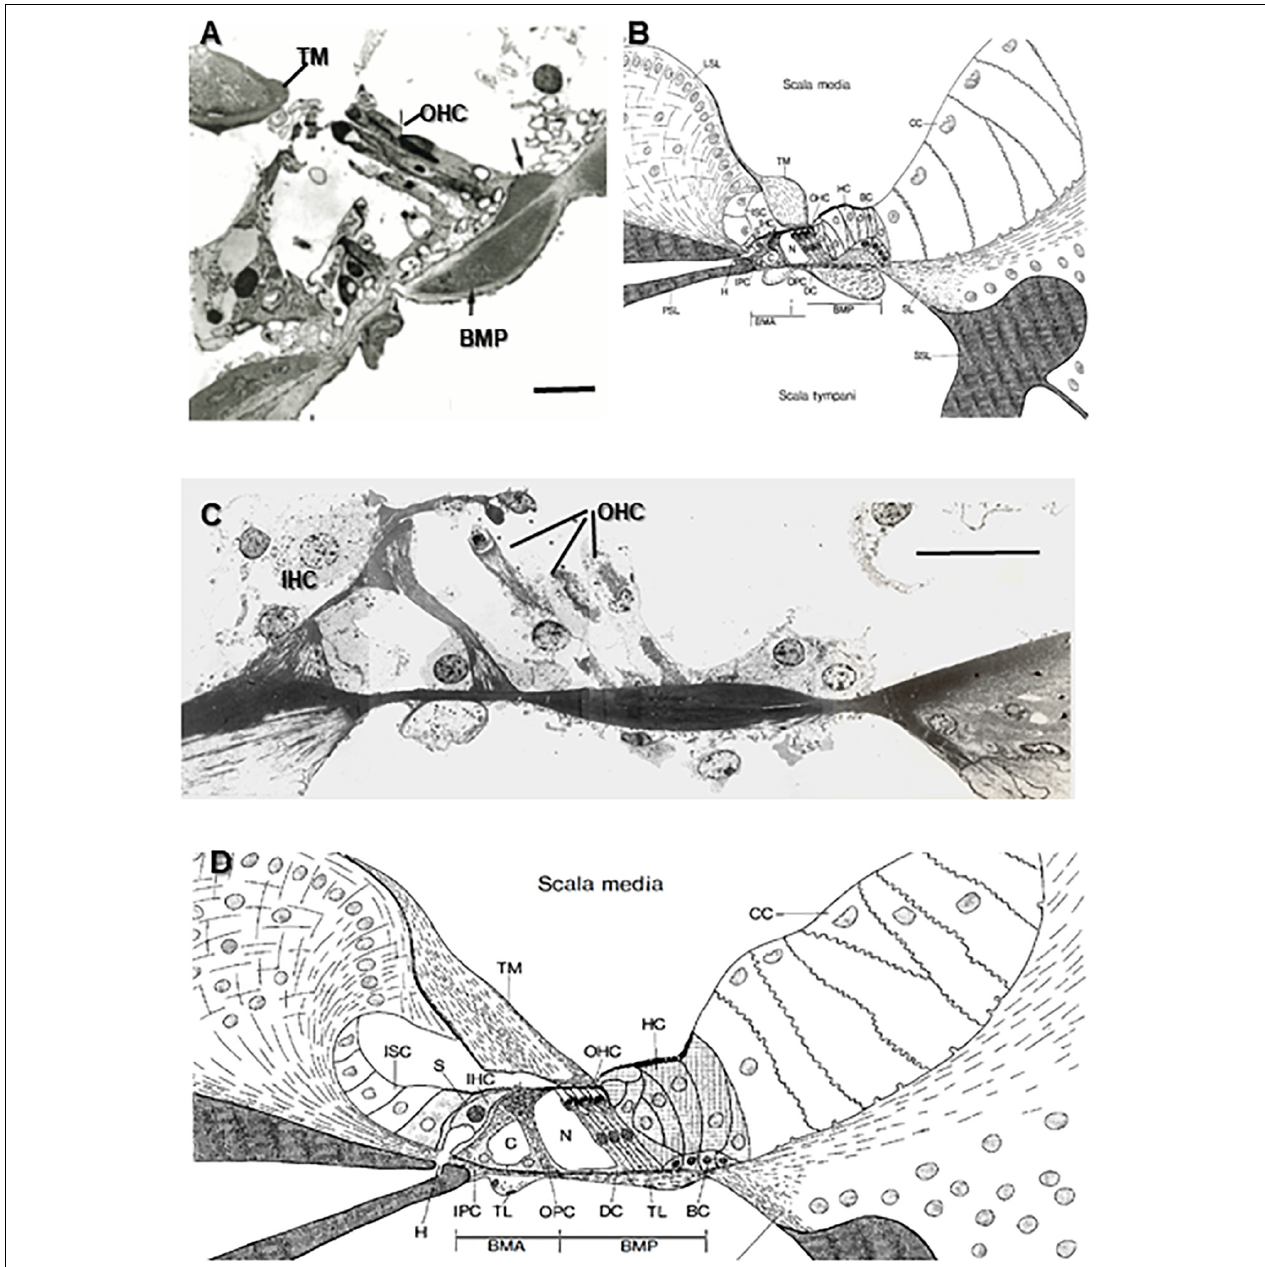
FIGURE 5 | Transmission electron microscopy (TEM) images of odontocete basilar membranes and organ of Corti compared with schematics of the cochlear sections from the horseshoe bat ( Rhinolophus ferrumequinum ). The specialized basal regions of the porpoise and bat have similar thickened regions of collagen fibers (arrows) attached to the basilar membrane that run longitudinally (scala media side) and transverse/radially (scala tympani side) that are hypothesized to act as stiffening agents. In both species, the outer hair cells (OHC) sit atop the bundle of longitudinal fibers. Specialized bundles are absent in the upper basal and second turn of the bottlenose dolphin and bat. Note: Because the OHC are actually staggered, all three may not be fully shown in the TEM images. This is not indicative of hair cell loss. BMA, Arcuate zone of the basilar membrane; BMP, Pectinate zone of the basilar membrane; C, Tunnel of Corti; CC, Claudius’ cells; DC, Deiters’ cells; H, Habenula; HC, Hensen’s cells; IHC, Inner hair cells; IPC, Inner pillar cells; ISC, Inner sulcus cells; LSL, Limbus of the spiral lamina; N, Nuel’s space; OHC, Outer hair cells; OPC, Outer pillar cells; PSL, Primary spiral lamina; S, IHC supporting cells; SL, Spiral ligament; SSL, Secondary spiral lamina; TL, Tympanic layer; TM, Tectorial membrane. Scale bars = 0.02 mm [TEM images copyright© 2021 DK, all rights reserved. Diagrams from Bruns (1980) reprinted by permission from Nature/Springer from Anatomy and Embryology, vol. 161]. (A) TEM image from the specially adapted lower basal half turn of a harbor porpoise ( P. phocoena , 1200X magnification). (B) Schematic from Bruns (1980) of lower basal turn location in the horseshoe bat (right, R. ferrumequinum ). (C) TEM image from the unspecialized region of the upper basal turn in a bottlenose dolphin ( T. truncatus 2000X magnification). (D) Schematic of the basilar membrane and organ of Corti in a horseshoe bat ( R. ferrumequinum ) in the unspecialized upper second